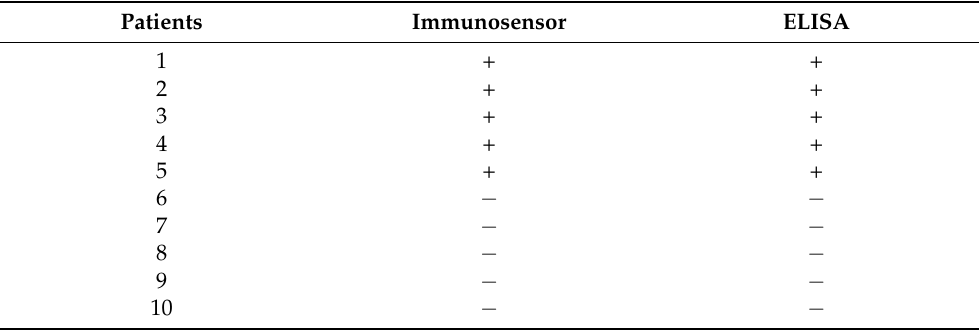
Table 1. Detection of IgG-SARS-CoV-2 in blood serum samples using the proposed immunosensor and the ELISA